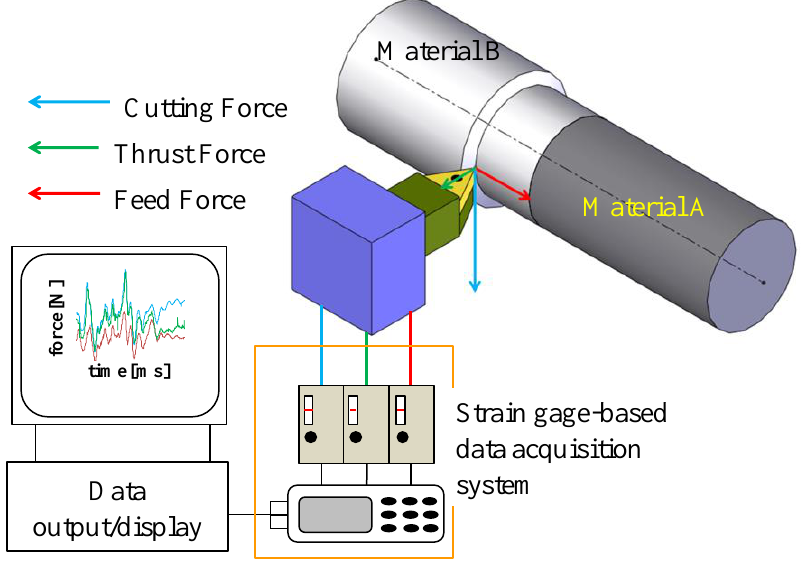
Figure 2. Experimental setup.